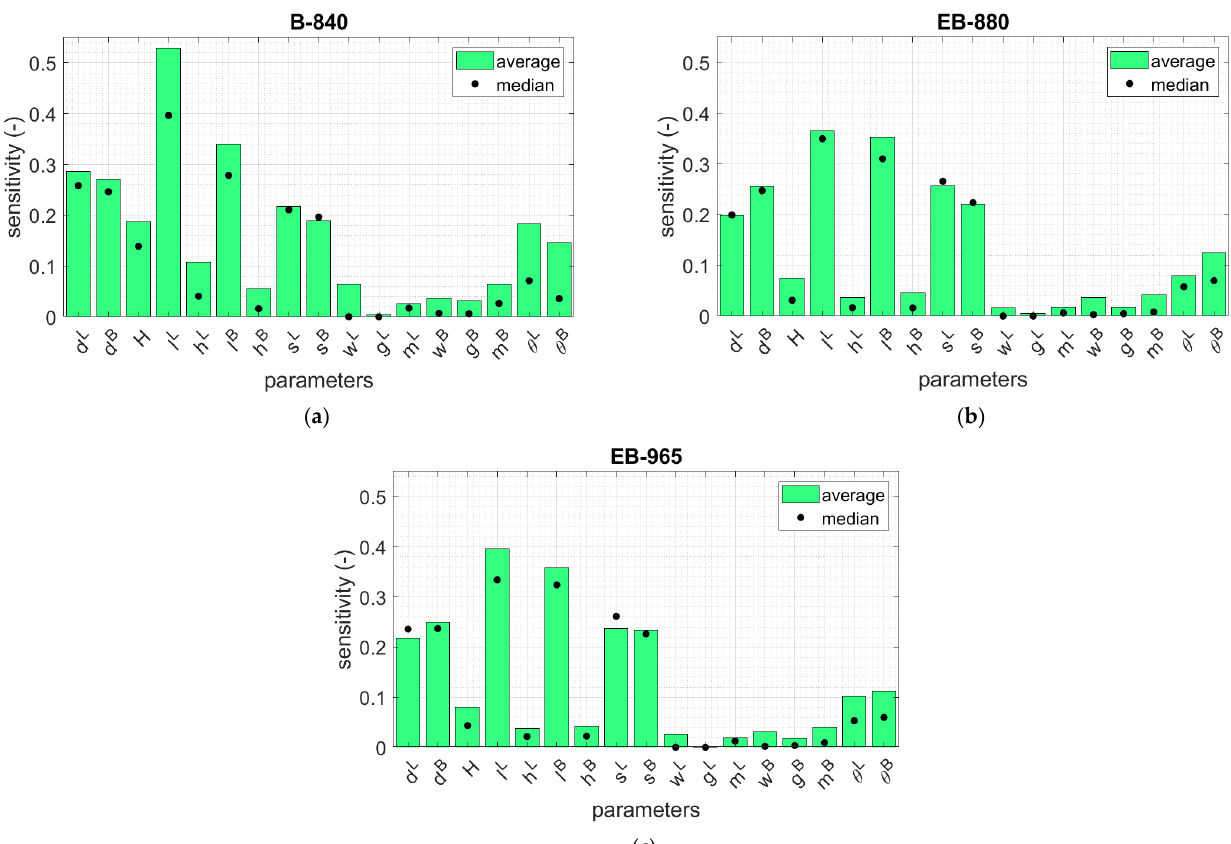
Figure 8. The averaged values of parameter sensitivities for three corrugated cardboards considered (sorted in ascending order).